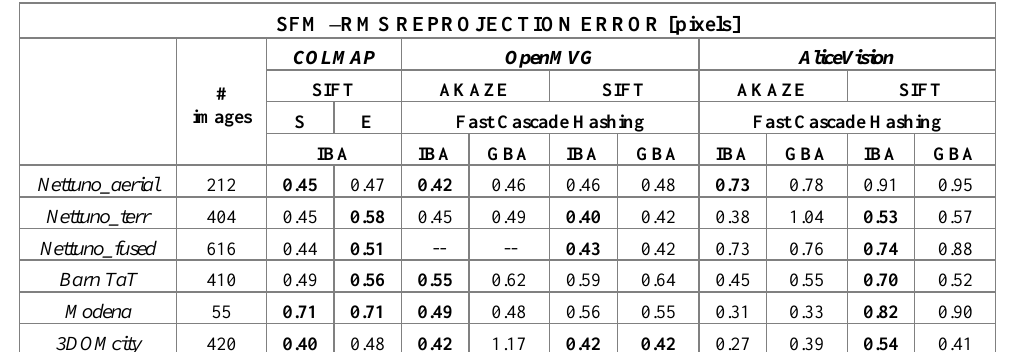
Table 5. RMS reprojection error (pixel) for each pipeline. S: sequential; E: exhaustive; IBA: incremental bundle adjustment; GBA: global bundle adjustment. Best achieved results per dataset and pipeline are highlighted in